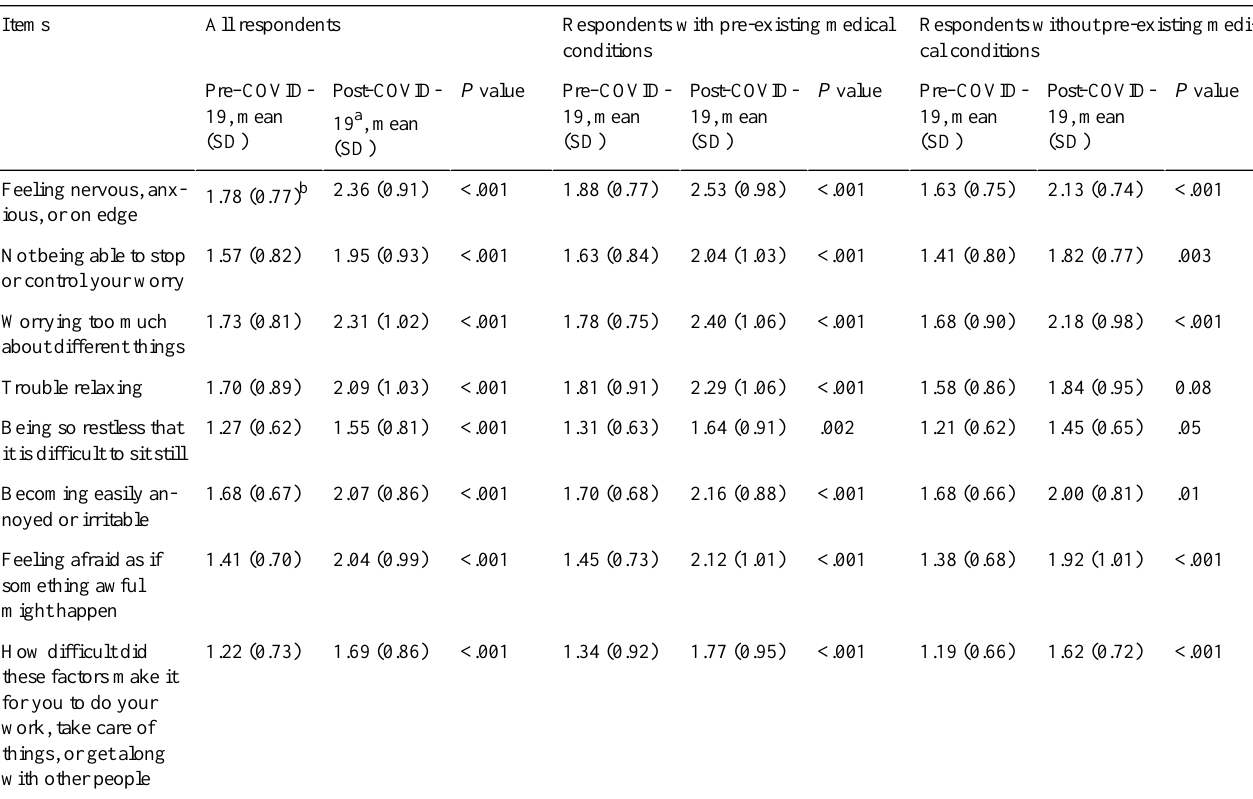
Table 3. Changes in psychological health resulting from the COVID-19 pandemic.